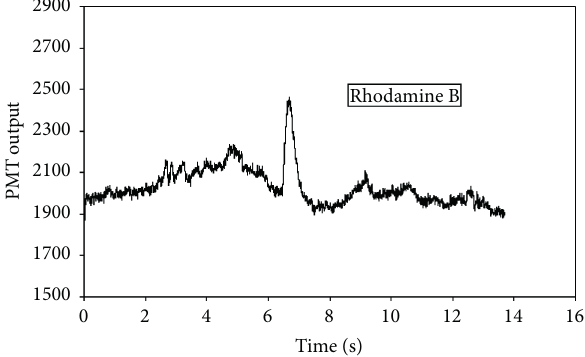
Figure 5: A chromatograph showing the peak for retained dyes observed during elution with methanol at a flow rate of 0.23 𝜇